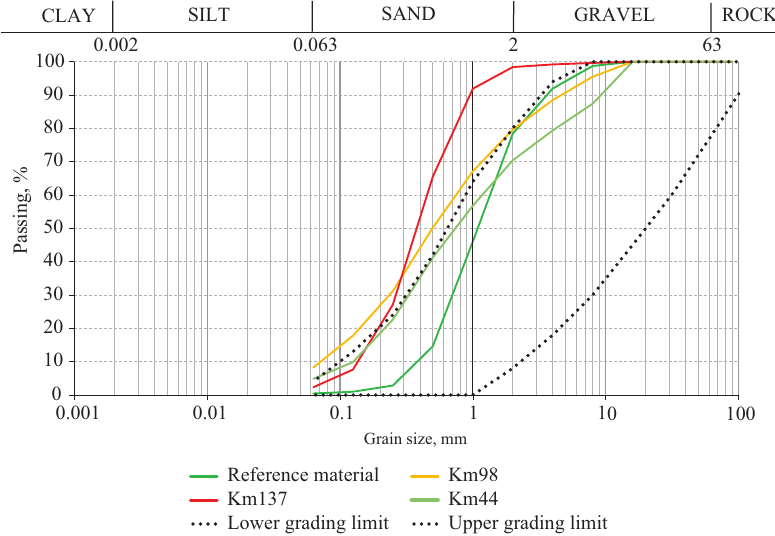
Figure 2. Particle sizes of the materials used in the laboratory